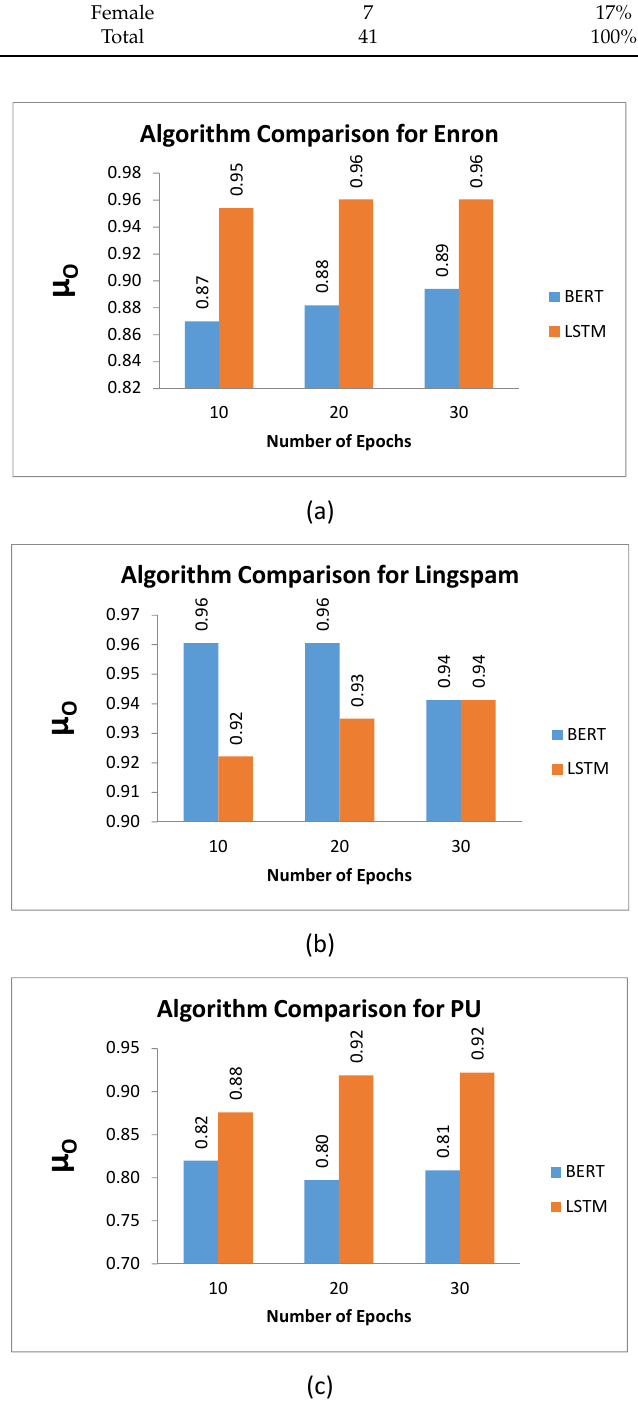
Figure 1. Comparison of BERT and LSTM using µ O for ( a ) Enron ( b ) Lingspam ( c )